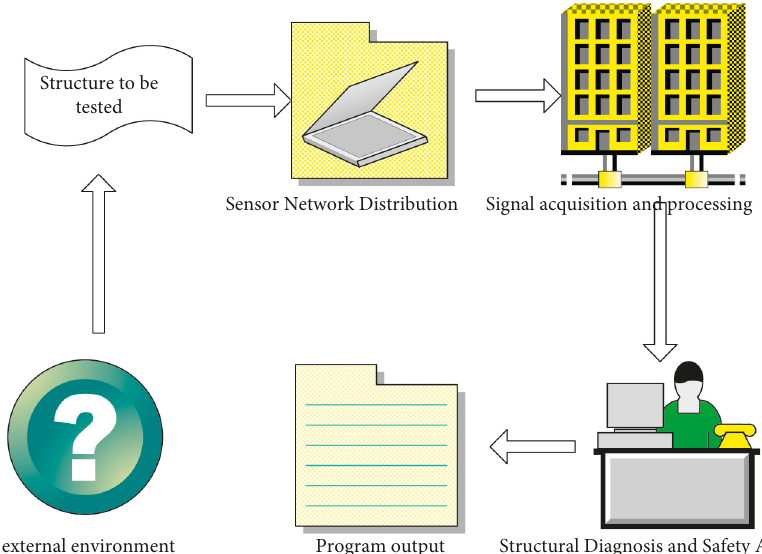
Figure 3: Sensor response to temperature system.